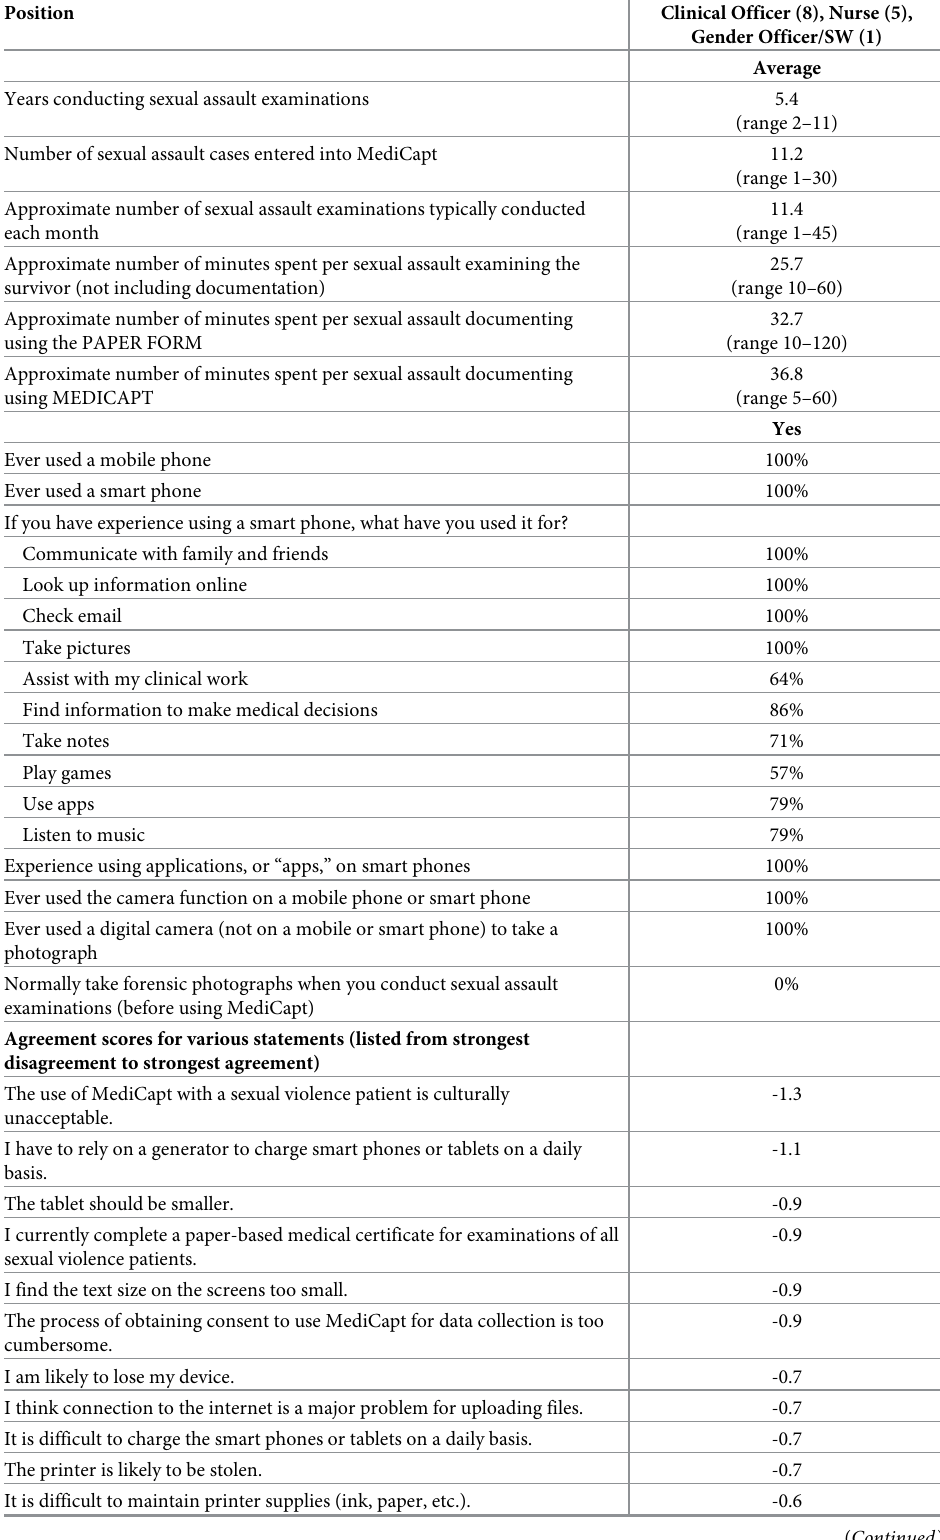
Table 2. Results of closed-response portion of the MediCapt usability